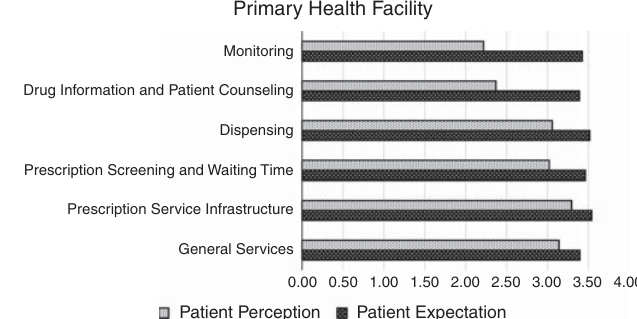
Figure 1. Patient expectation and perception of pharmaceutical